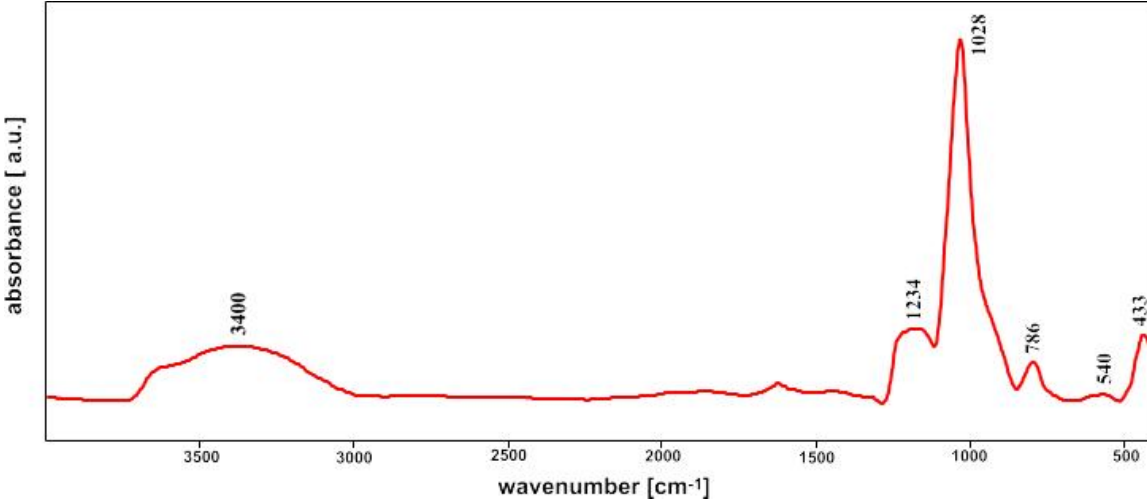
Figure 5. FTIR spectrum of the thin film synthesized from the basic containing TEOS sol (5% mas. SiO 2 ) and deposited on steel substrate.